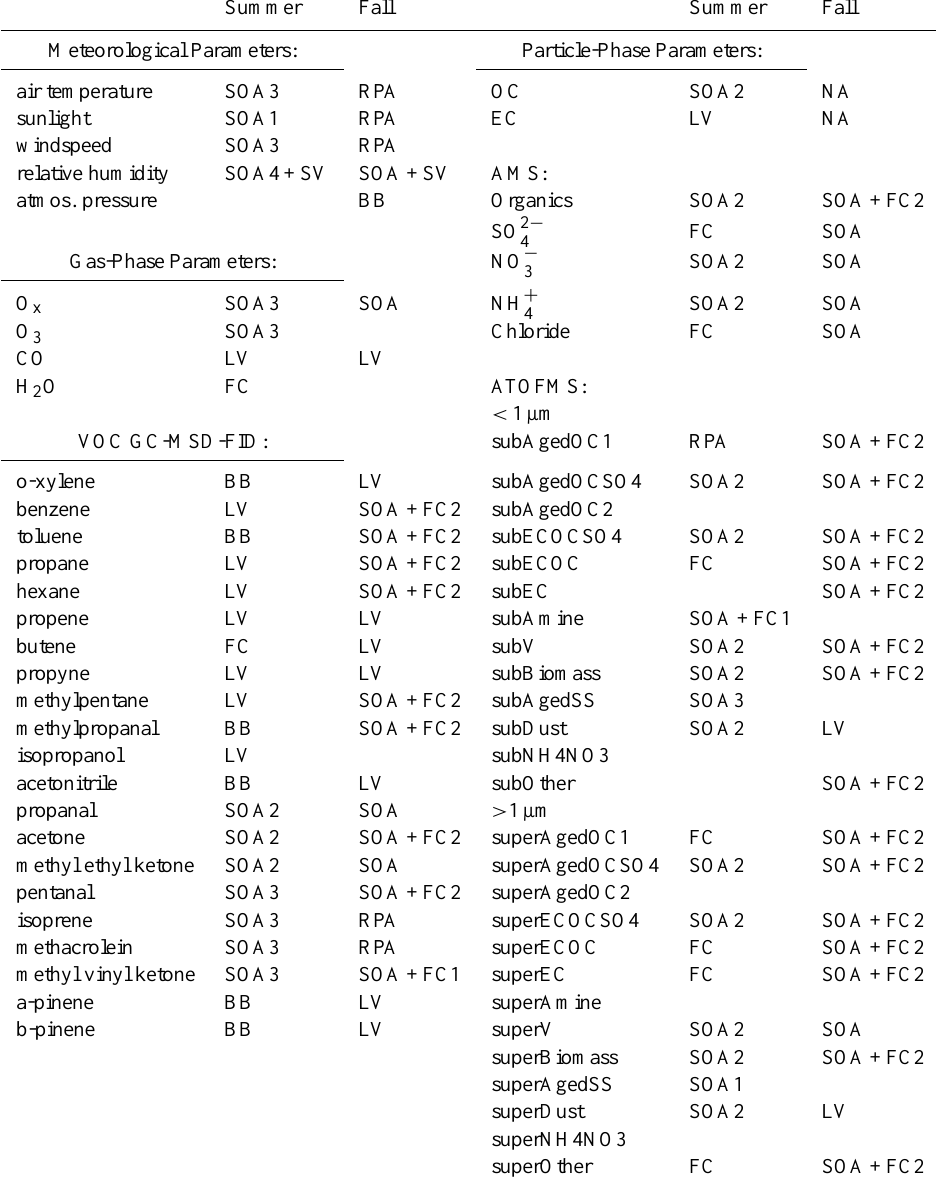
Table 2. Highest Correlations ( r > 0 . 4) between TAG Factors and Other Relevant Parameters. Summer Fall Summer Fall Meteorological Parameters: Particle-Phase Parameters: air temperature SOA3 SOA2